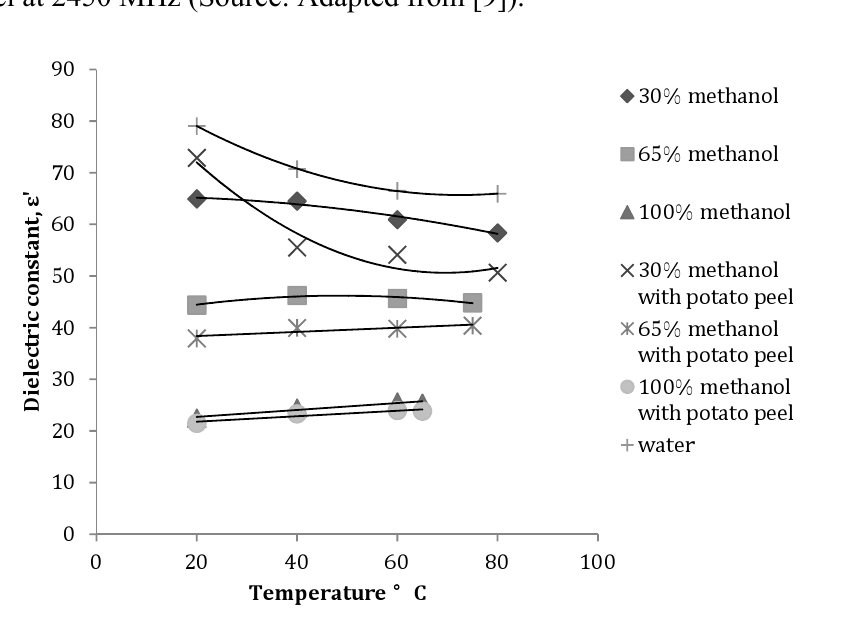
Figure 2. Variation in dielectric constant of a methanol-water mixture with and without potato peel at 2450 MHz (Source: Adapted from